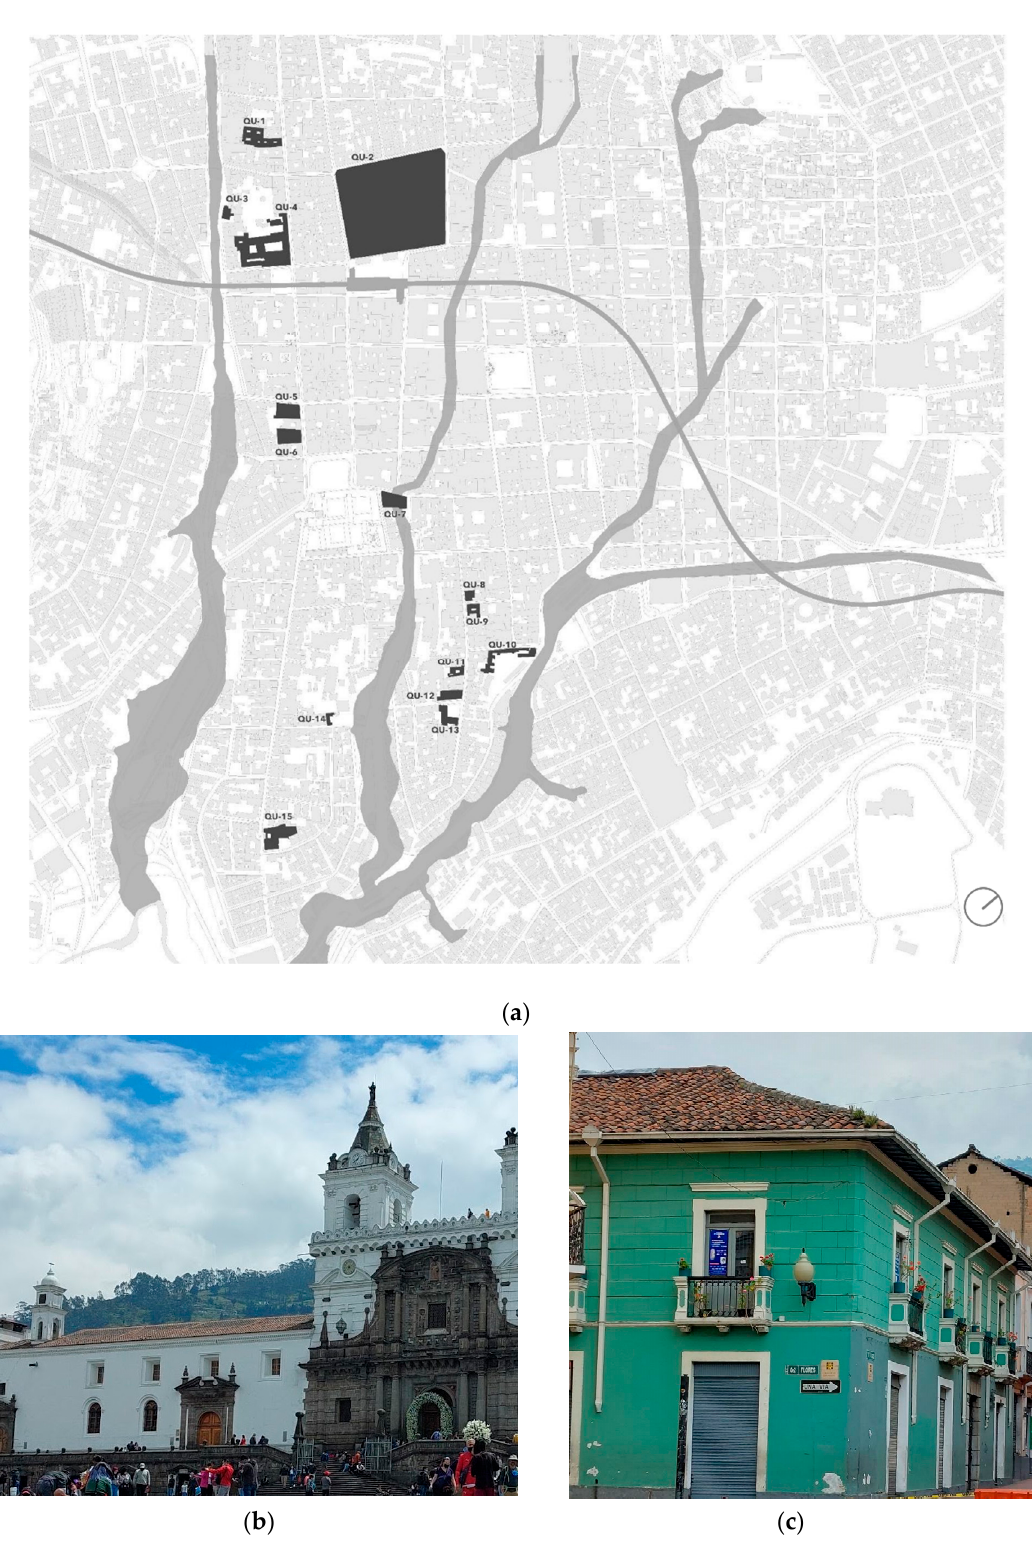
Figure 5. ( a ) Case study map. Scale: 1:8500. ( b ) Picture of a religious building. ( c ) Picture of a resi- dential building. residential